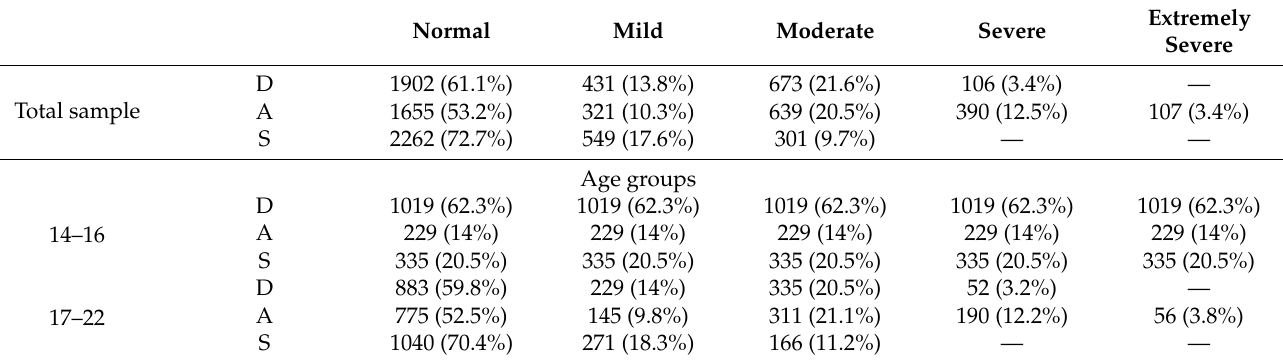
Table 4. DASS-21 severity distribution between the overall sample, age groups, gender, school